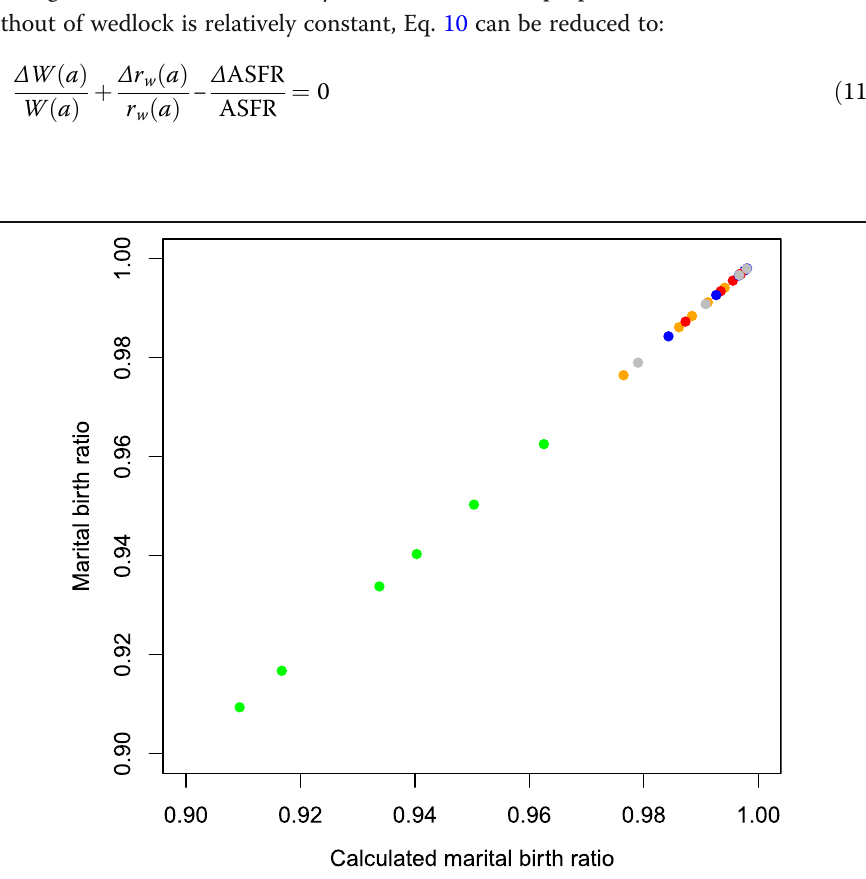
Fig. 3 The marital birth ratio, b w , vs. the calculated marital birth ratio based off marriage and fertility data for all 5-year age groups except ages 15 – 19 and years of 1941, 1950, 1960, 1970, 1980, and 1990 for Swiss women. Colors for age groups are 20 – 24 (green), 25 – 29 (orange), 30 – 34 (red), 35 – 39 (blue), and 40 – 44 (gray). The measured R 2 is 0.99. The 15 – 19 age group is excluded due to gaps in marriage data up until 1980. See details in